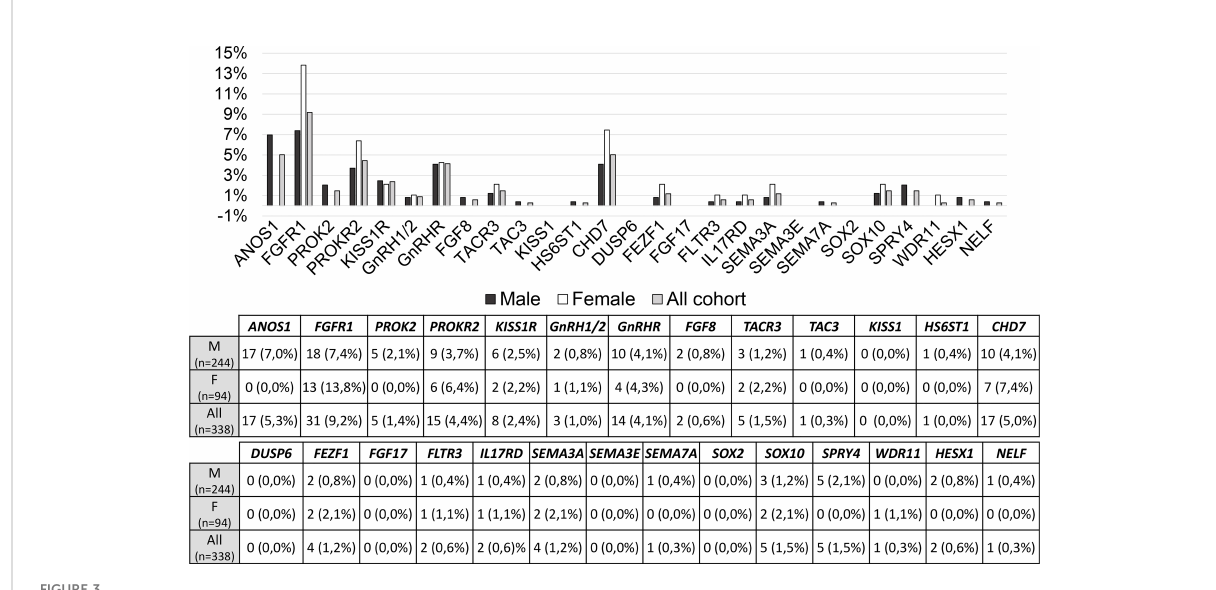
FIGURE 3 Prevalence of rare genetic variants in each candidate gene. RVs, rare genetic variants.